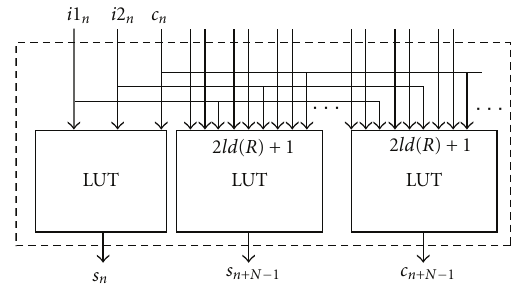
Figure 7: The high radix adder mapped to LUTs.